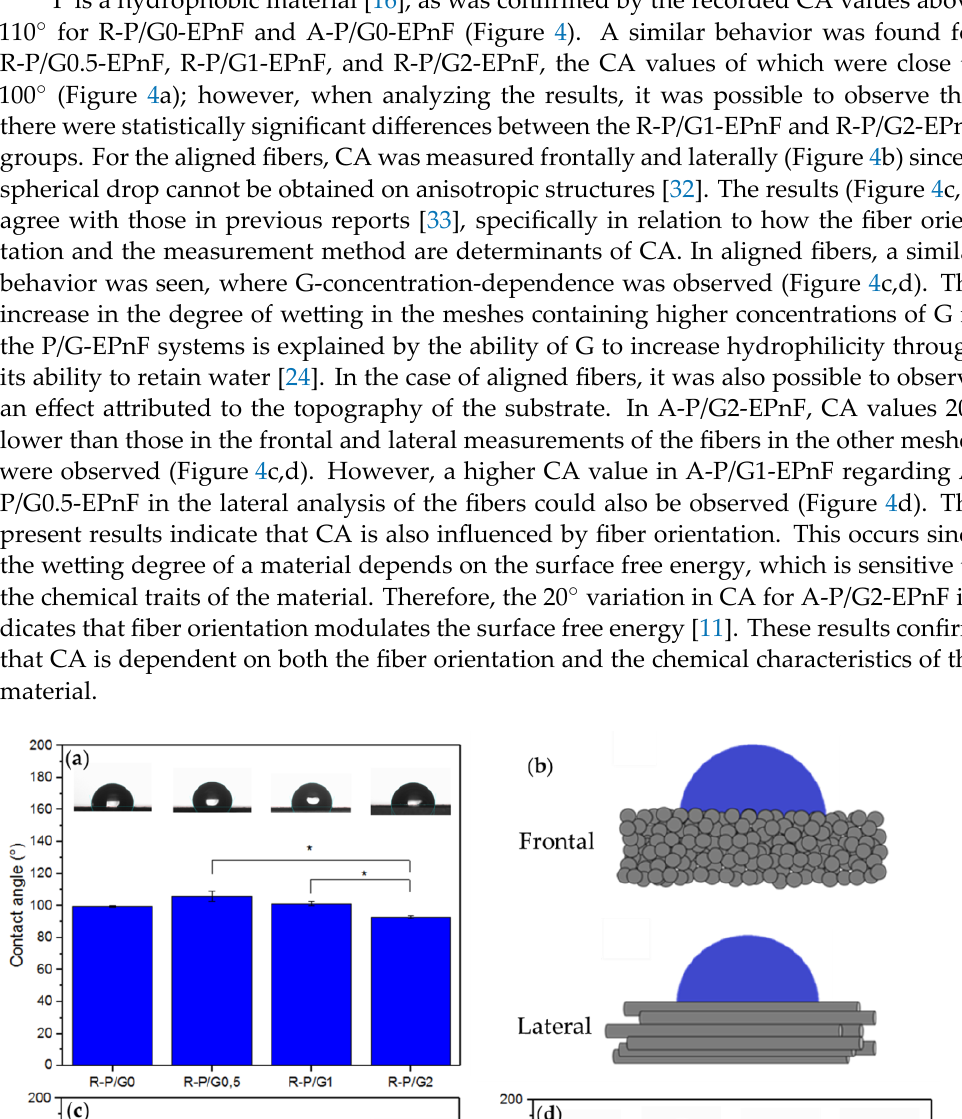
Figure 3. ATR/FT-IR spectra of (purple) G, (black) P/G0-EPnF, (green) P/G0.5-EPnF, (blue) P/G1- EPnF, and (red) P/G2-EPnF. Insets 1 and 2 show zoomed-in images of the absorption bands of G at